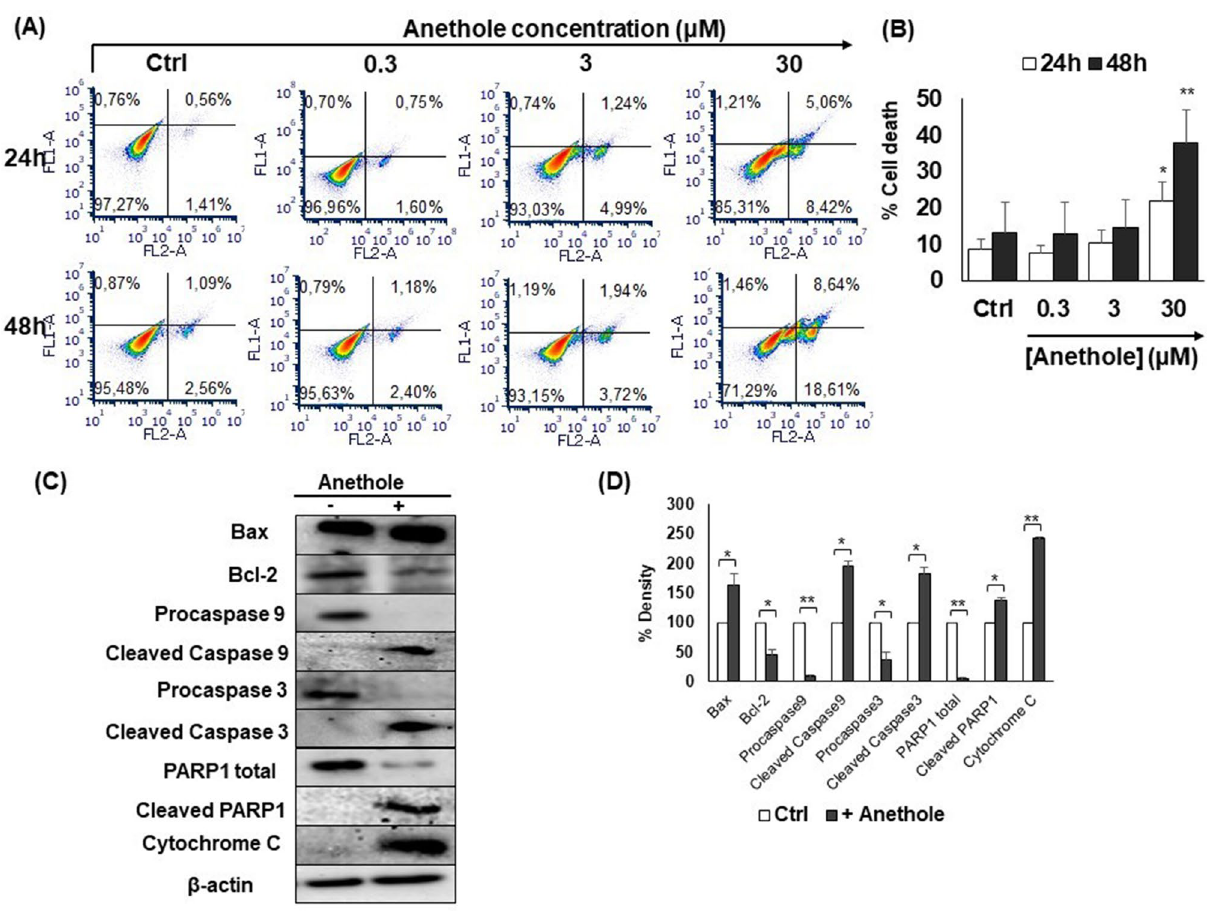
Figure 2. Anethole induces apoptosis of oral cancer cells. ( A ) Mouth epidermoid carcinoma cells (Ca9-22) were exposed to different concentrations of anethole (0.3 μM to 30 μM) for 24 h or 48 h. Apoptosis/necrosis was measured with an annexin V/PI kit and analyzed by flow cytometry (n = 3). Controls was being used to determinate the gates. ( B ) Histogram displays flow cytometry results of Ca9-22 cell apoptosis/necrosis after 24 h and 48 h of anethole exposure. Results are reported with means (% of death) ± SD. ( C ) Western blotting confirmed the involvement of apoptotic pathways and expression after being exposed with anethole 10 μM for 24 h. Proteins were extracted with the Bradford technique before migration on SDS-PAGE (7 to 15%). β-actin was used as control (n = 3). ( D ) Represents a histograms showing fold changes of indicated proteins. 100% was the density of untreated